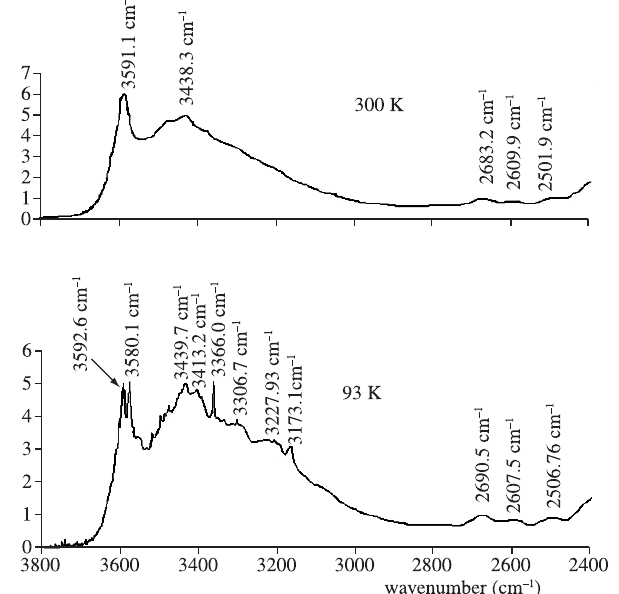
Figure 1. Infrared spectra at 300 and 93 K of the amethyst from Brumado, Bahia, Brazil after heating to colorless state.